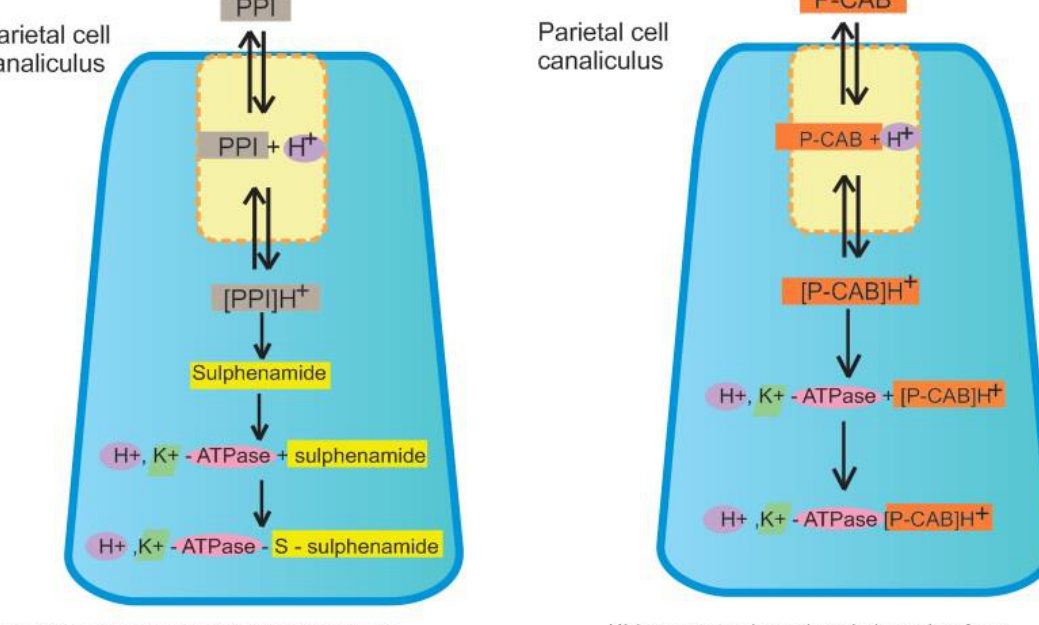
Figure 1. The mode of action of proton pump inhibitors (PPIs) and Vonoprazan against H. pylori infection. PPI enters parietal cell canaliculus in inactive form and requires acid activation. Protonated pro-drugs will convert to sulphenamide and bond covalently with cysteine groups of H + / K + -ATPase that cause inactivation of H + / K + -ATPase. Unlike PPI, potassium-competitive acid blocker (P-CAB) enters parietal cell canaliculus in active form, has stability in an acidic environment, and does not require acid activation. Protonated P-CAB will make non-covalent bonds with H + / K + -ATPase, thus inactivating the H + / K + -ATPase with a slower dissociation rate and for longer time. * Lacks of PPIs in gastric acid inhibition; ** Benefits of vonoprazan in gastric acid